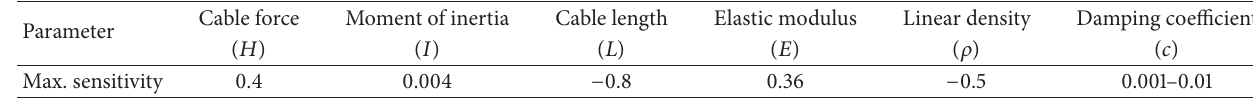
Table 1: Results of sensitivity